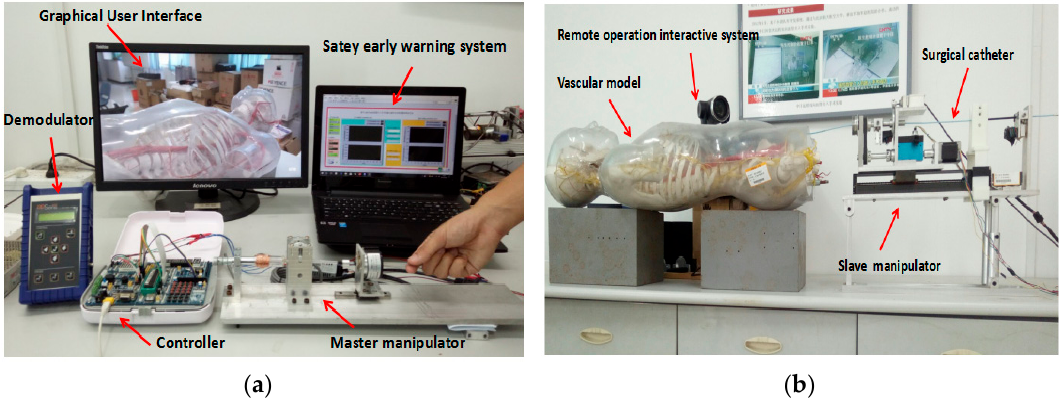
Figure 9. The master–slave, minimally-invasive robotic system for vascular intervention ( a ) The master (doctor) side; ( b ) The slave (patient) side.